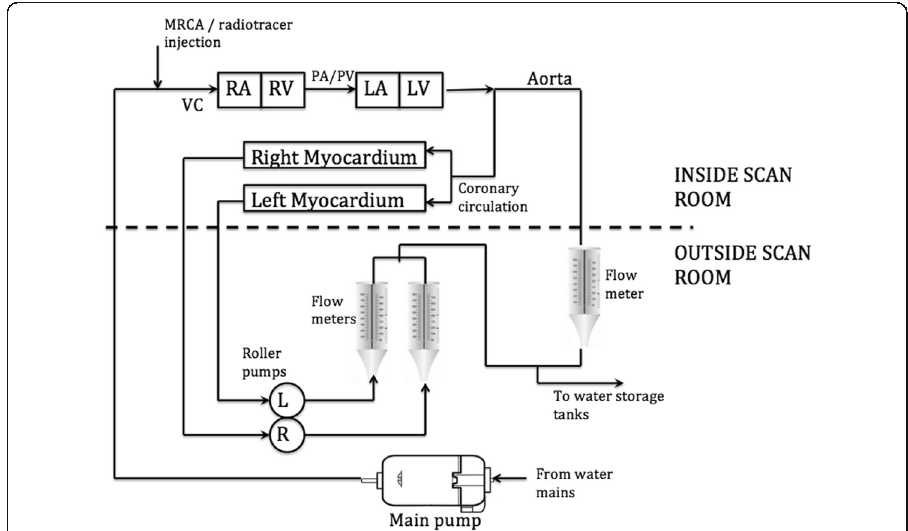
Fig. 1 Basic schematic representation of the phantom showing the control unit outside the scan room and the phantom components inside the PET-MR scanner. VC = vena cava, PA/PV-pulmonary artery/vein, RA/ LA = right/left atrium, RV/LV-right/left ventricle. Image modified from Chiribiri et al. (Chiribiri et al.,